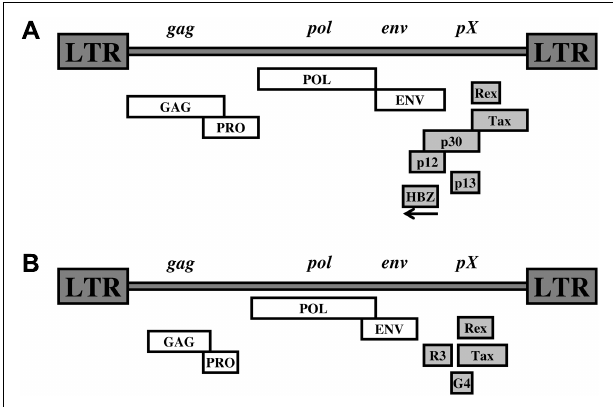
FIGURE 1 | (A) HTLV-1 proviral genone. (B) BLV-1 proviral genome.